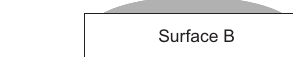
contact angles of a drop on R